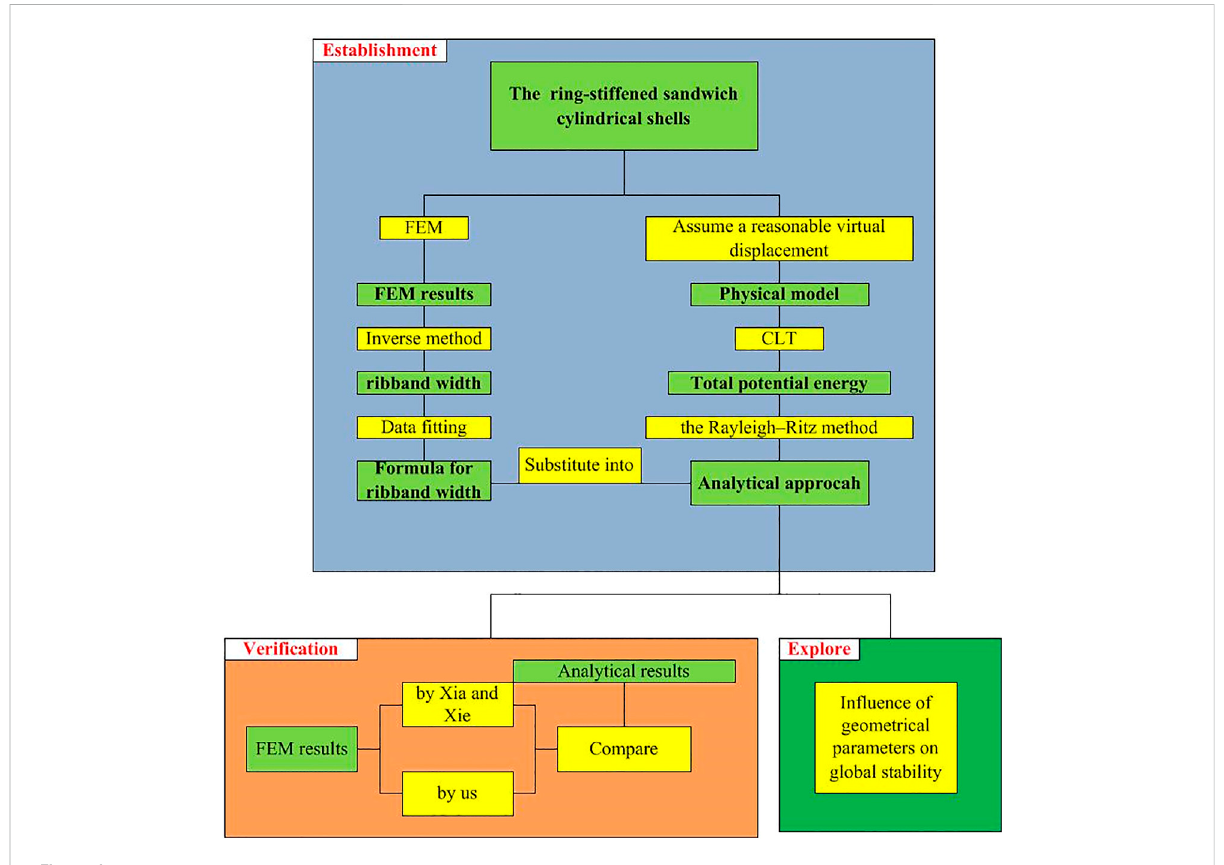
Figure 1 The illustration of the organization of this